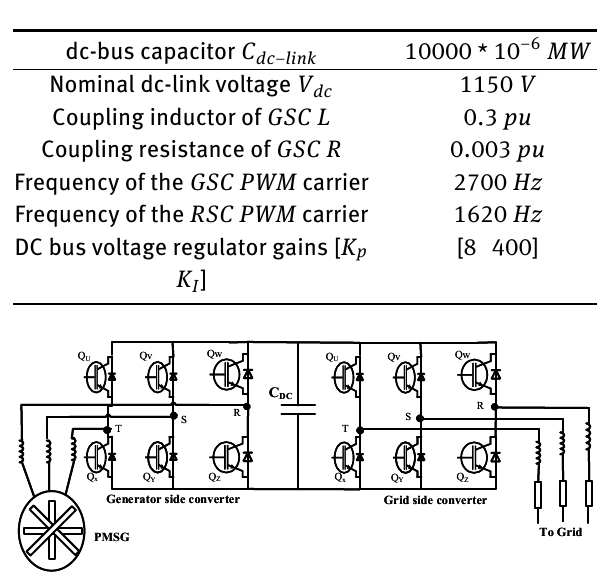
Figure 15: Control strategy for the turbine pitch angle β [21]. Table 3: DC -link Parameters